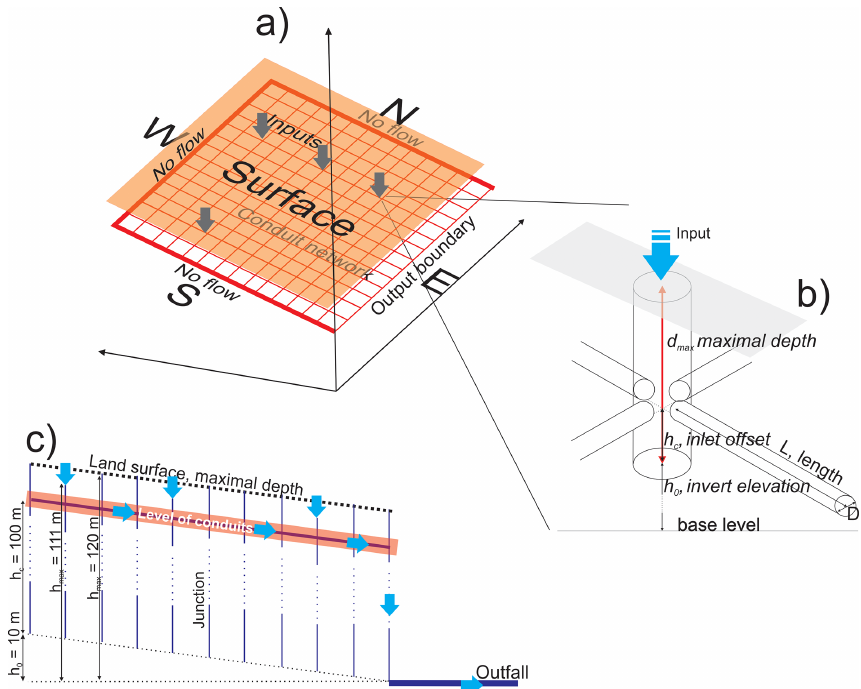
Figure 6. The model structure for the low-dip network. (a) A conduit network with discrete water inputs, marked by arrows. Boundaries are denoted geographically. Outputs are along the E boundary. (b) Geometry and parameters of a junction. (c) The side view of the model, also showing a large conduit connecting E junctions to an outfall.